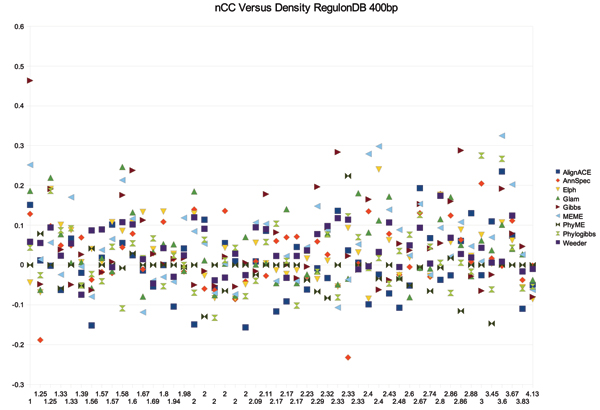
Density of the binding sites in Tk versus nCC.